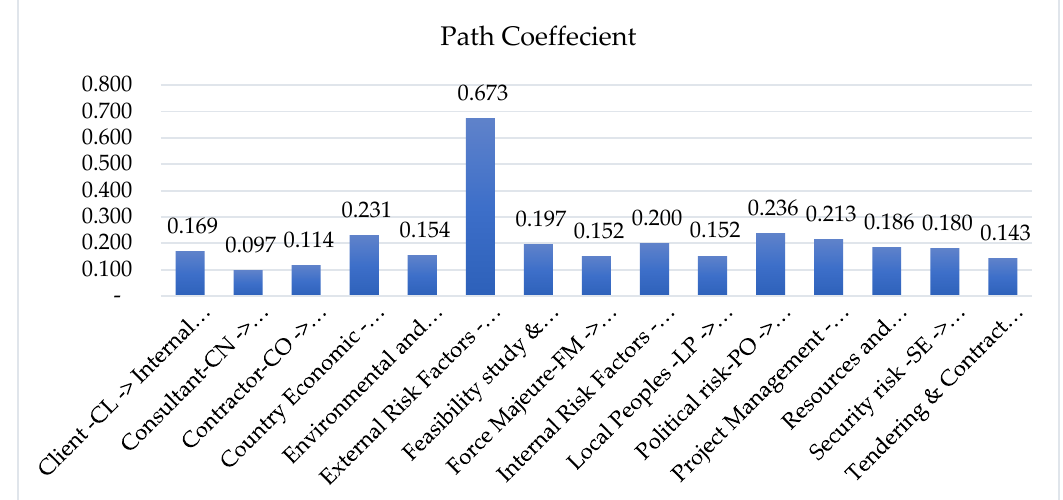
Figure 8. Path coefficient values for the research model.